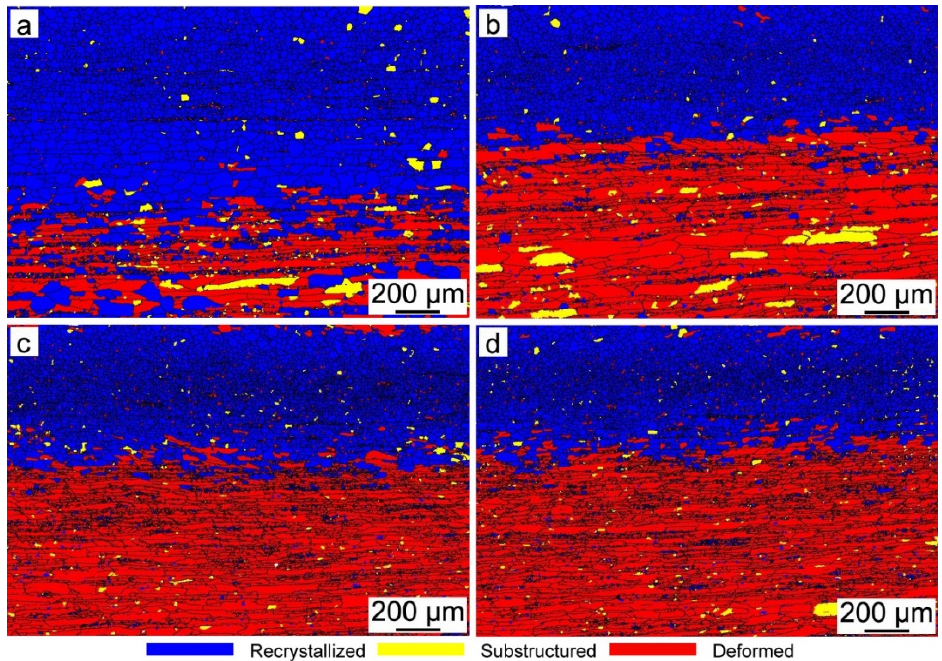
Figure 5. EBSD analysis of recrystallized microstructure of hot-rolled bands: ( a ) Nb-free, ( b ) Nb- 0.005 wt%, ( c ) Nb-0.009 wt% and ( d ) Nb-0.025 wt%.